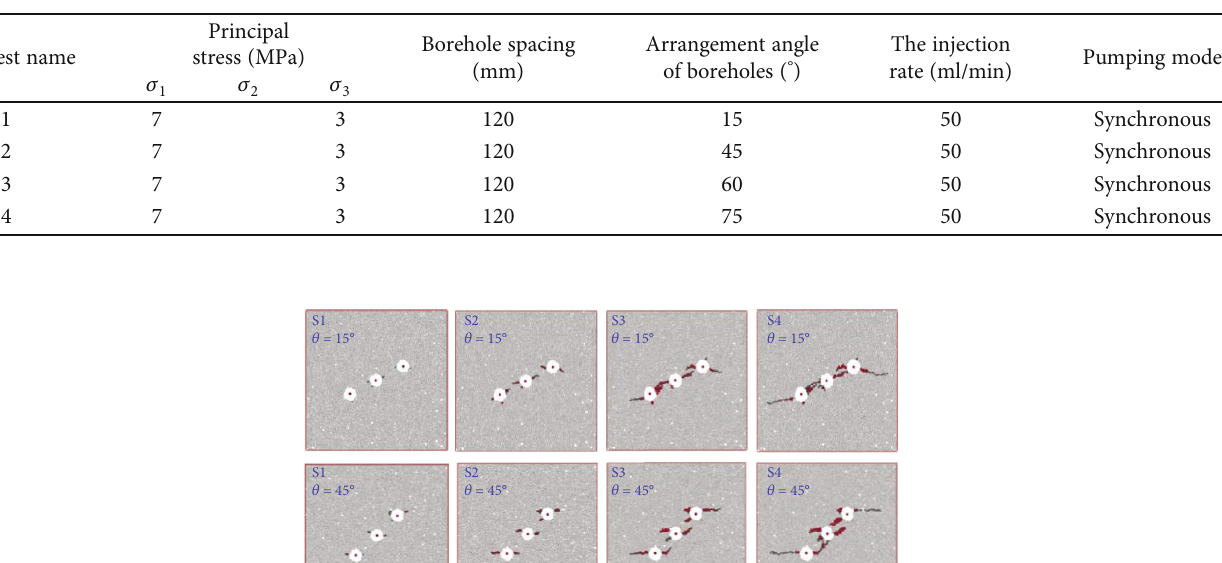
Table 4: Experimental scheme of directional hydraulic fracturing.